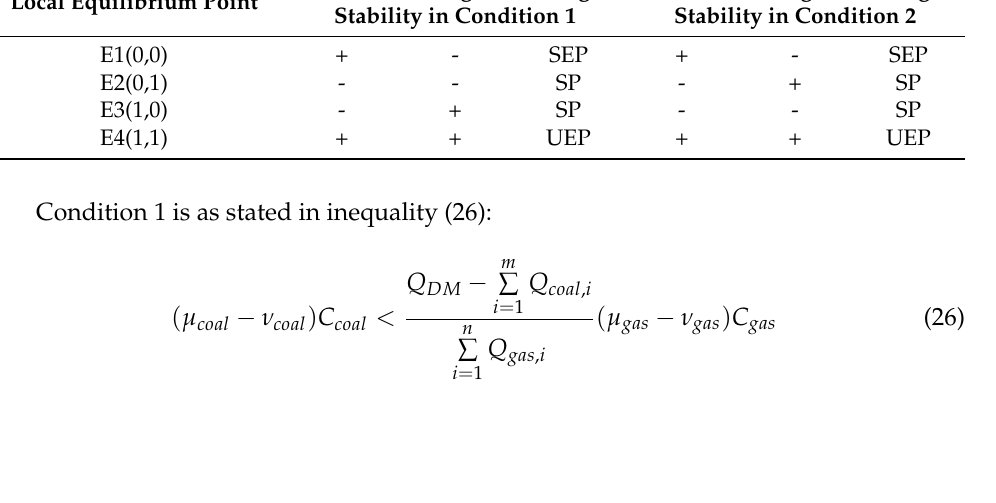
Determinant Sign, Trace Sign, Stability in Condition